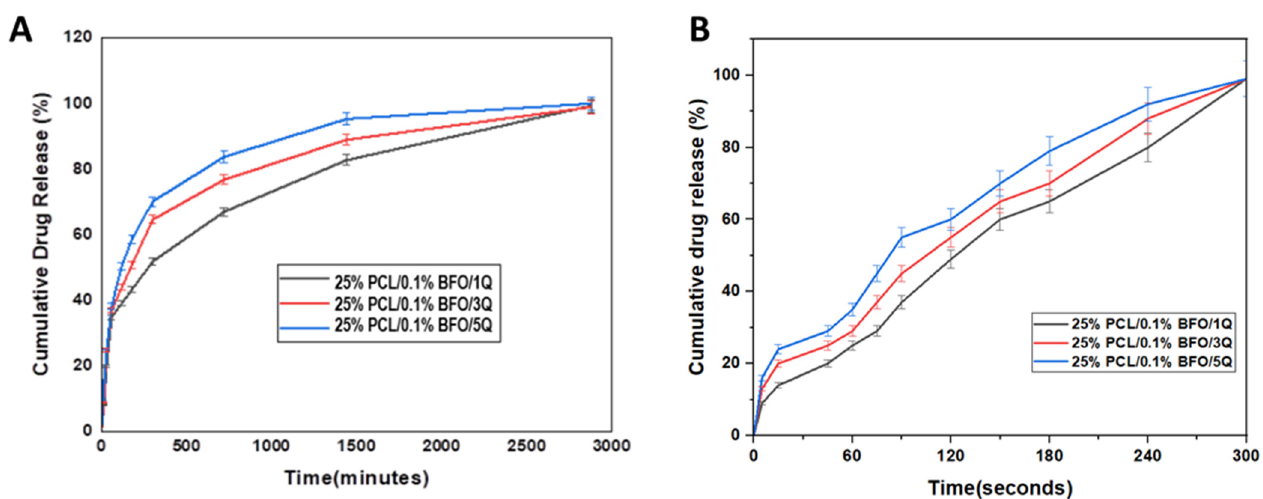
Figure 5. Cumulative drug-release graph of Q from the drug-loaded microfibrous scaffolds ( A ), and under electric stimulus with 50 Hz frequency ( B ). Electrically triggered Q release from microfibrous scaffolds.